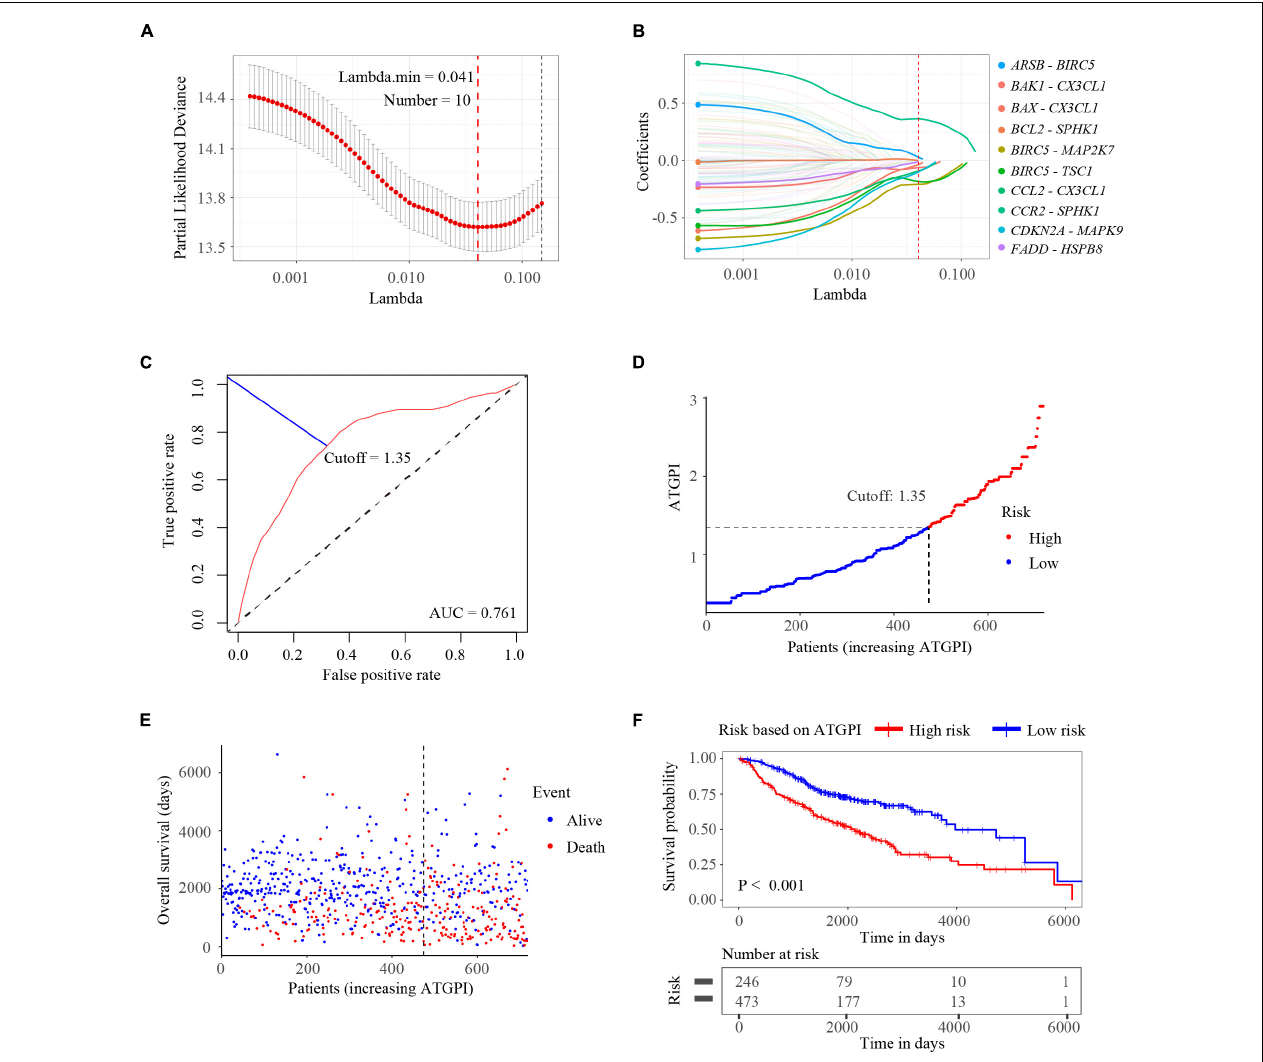
FIGURE 2 | Construction of the autophagy-related gene pair index (ATGPI), a classifier comprising 15 unique autophagy-related genes. (A) The penalty parameter was estimated by 10-fold cross-validation in the training data set at 1 SE beyond the minimum partial likelihood deviance. (B) The LASSO coefficient profiles of the 10 prominent autophagy-related gene pairs. (C) The optimal cutoff of the ATGPI for stratifying patients based on time-dependent receiver operator characteristic curve analysis in the training cohort. (D) The risk curve of the ATGPI in the training cohort. (E) The scatterplot of vital status of each patient in the training cohort. (F) The Kaplan-Meier survival curves of low and high ATGPI